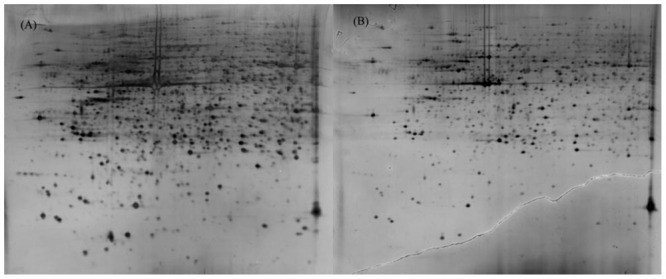
2-DE gel images of AIV-infected and control groups of A549 cells at 24 hpi. (A): 2-DE gel of the AIV-infected group. (B): 2-DE gel of the control group.